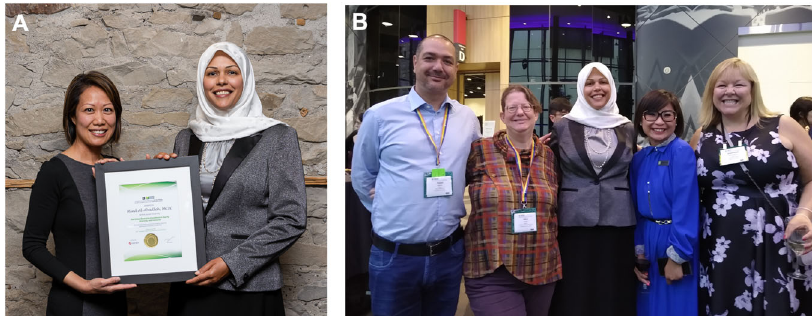
Fig. 1 Selected photos from the awards reception at the 2022 Canadian Chemistry Conference and Exhibition. Professor Hind Al-Abadleh with ( A ) Dr. Erica Tiong (Gilead Sciences) who presented the award, and ( B ) Dr. Tiago Vieira (Gilead Sciences), Professor Nola Etkin (University of Prince Edward Island and co-founding member of WIDE), Dr. Josephine Tsang (Executive Director, CIC), and Professor Stephanie MacQuarrie (Cape Breton University and Chair of WIDE). The author af fi rms that informed consent for publication of the images was obtained from the identi fi able